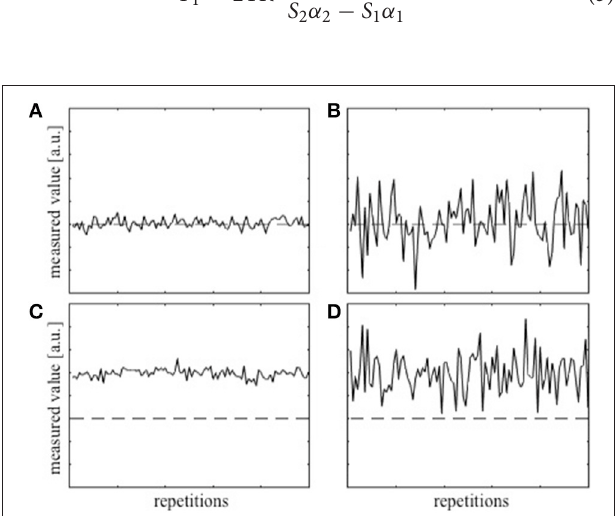
FIGURE 1 | Simulation of repeatedly measured data with (A) high accuracy and high precision, (B) high accuracy, but low precision, (C) low accuracy and high precision, and (D) low accuracy and low precision. The dashed lines represent the true